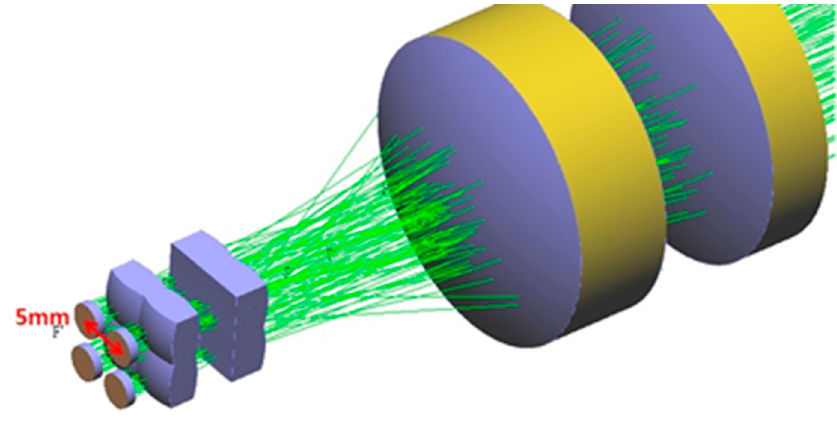
Figure 2. Optical path for green light source in a rectangular 2 × 2 array.